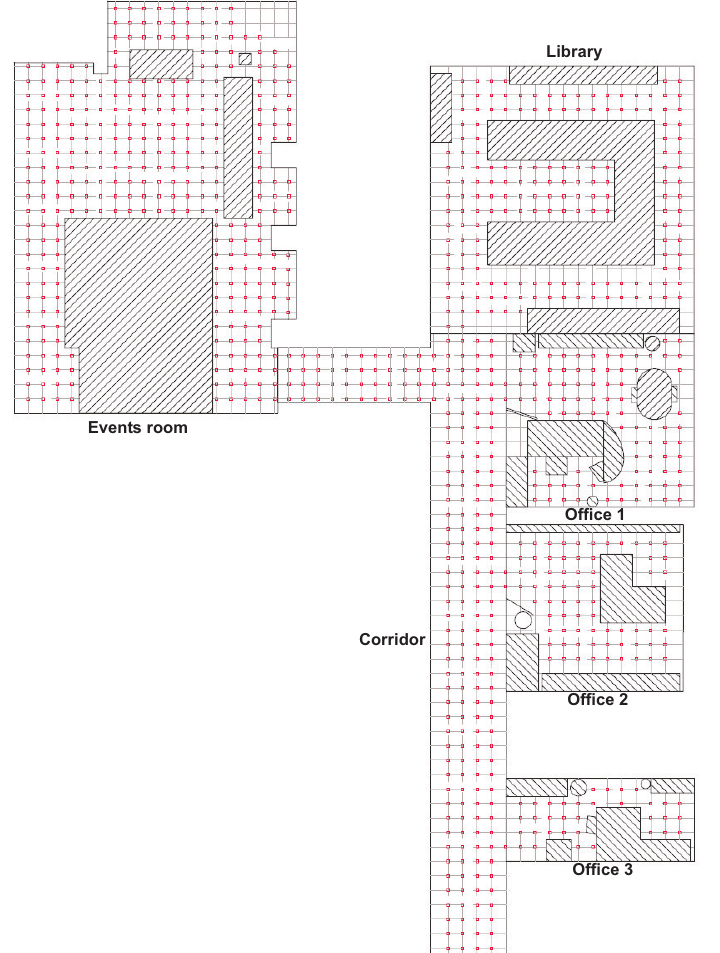
Figure 2. Bird’s eye view of the capture points of the training set of images. The size of the grid is 40 × 40 cm.